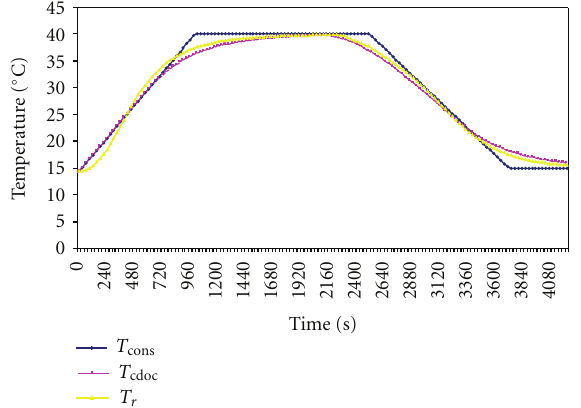
Figure 5: Evolution of temperature ( T cons ), the adjusted set-point ( T cdoc ), and reaction mixture ( T r ), K = 0.5, K r = 1. without provoking deterioration in the followup of the set- point profile.